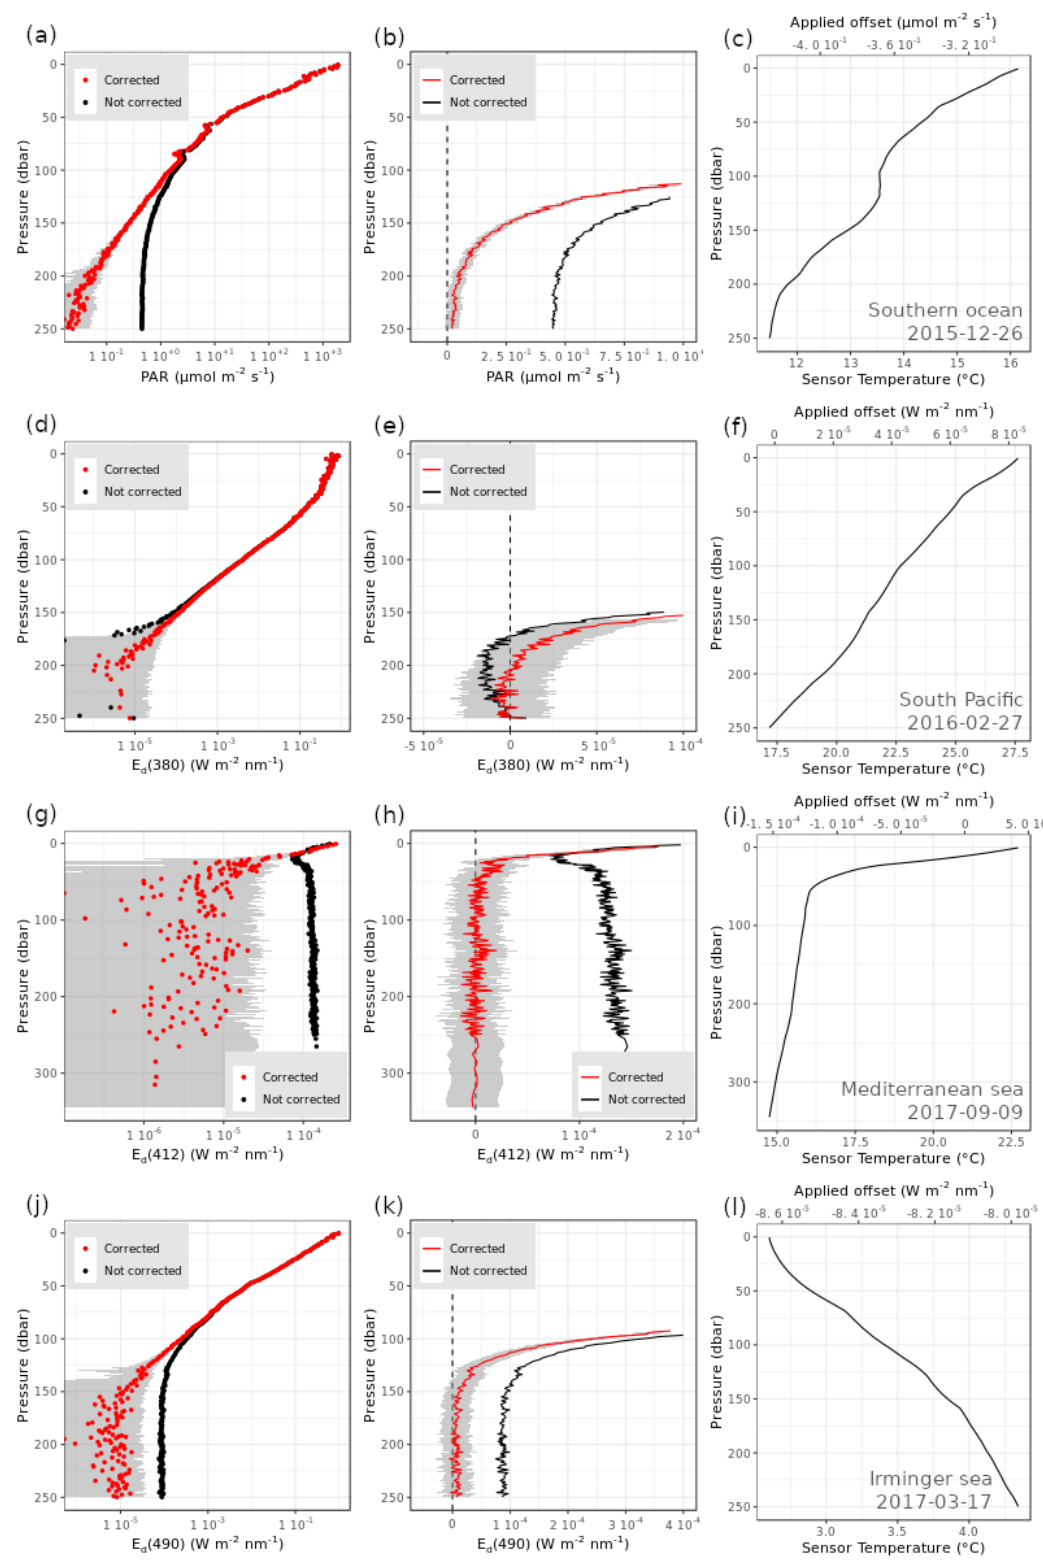
Figure 7. Examples of radiometry profiles before and after DM-QC: Left) profiles are shown in a semi-log scale; Centre) profiles are shown in a linear scale; Right) the reconstructed sensor internal temperature T s is shown (Equations (2)–(9)). Examples derive from four BGC-Argo floats deployed in oceanic regions characterized by diverse trophic and optical regimes: ( a – c ) Southern Ocean; ( d – f ) South Pacific subtropical gyre; ( g – i ) Mediterranean Sea; ( j – l ) North Atlantic subpolar gyre—Irminger Sea.